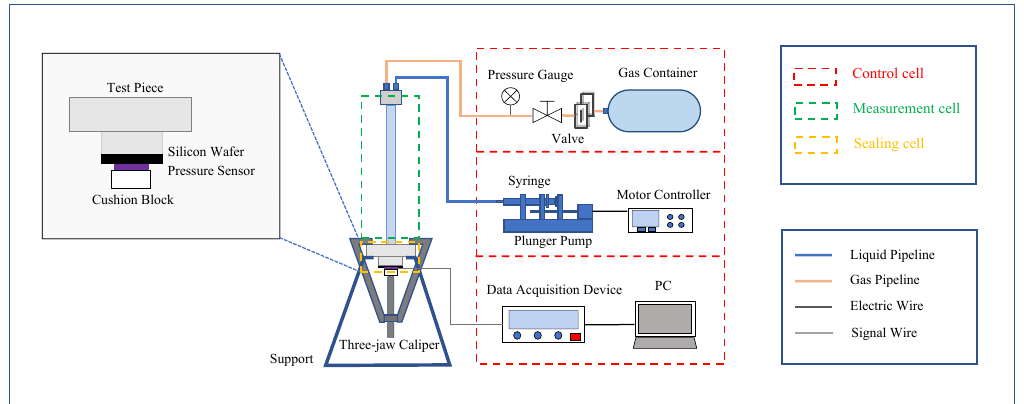
Figure 2. Schematic of the measurement